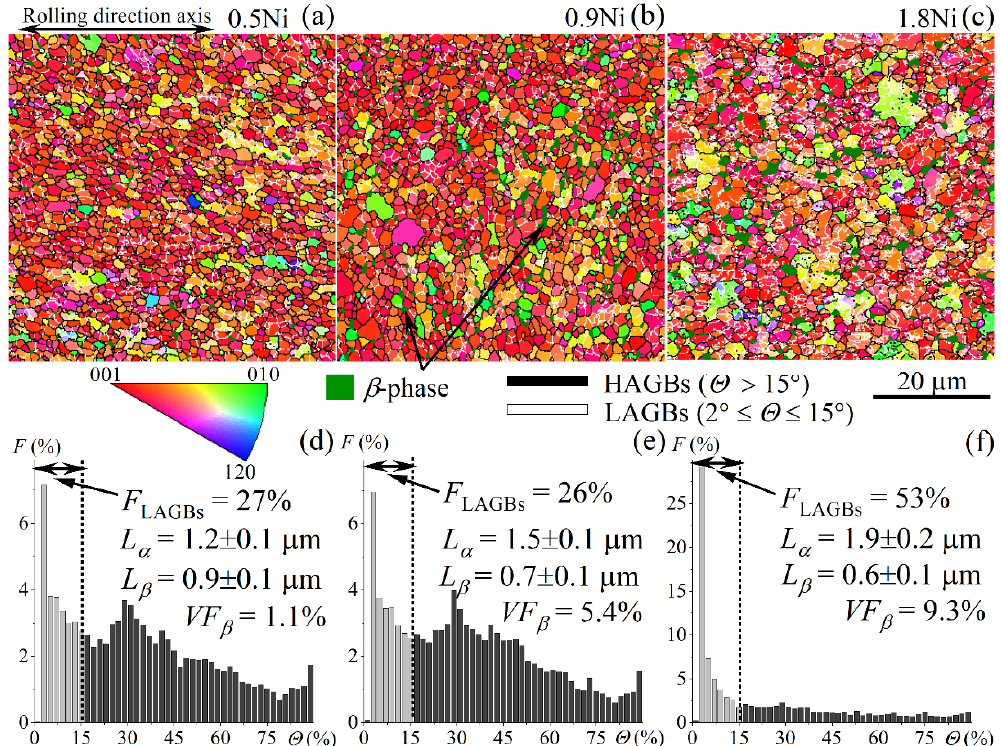
Figure 5. ( a – c ) Electron backscattered diffraction inverse pole figure (EBSD-IPF) grain boundary maps of the α phase and ( d – f ) the related grain boundary misorientation angle distributions for ( a , d ) the 0.5Ni, ( b , e ) 0.9Ni, and ( c , f ) 1.8Ni alloys after annealing for 30 min at 700 °C.